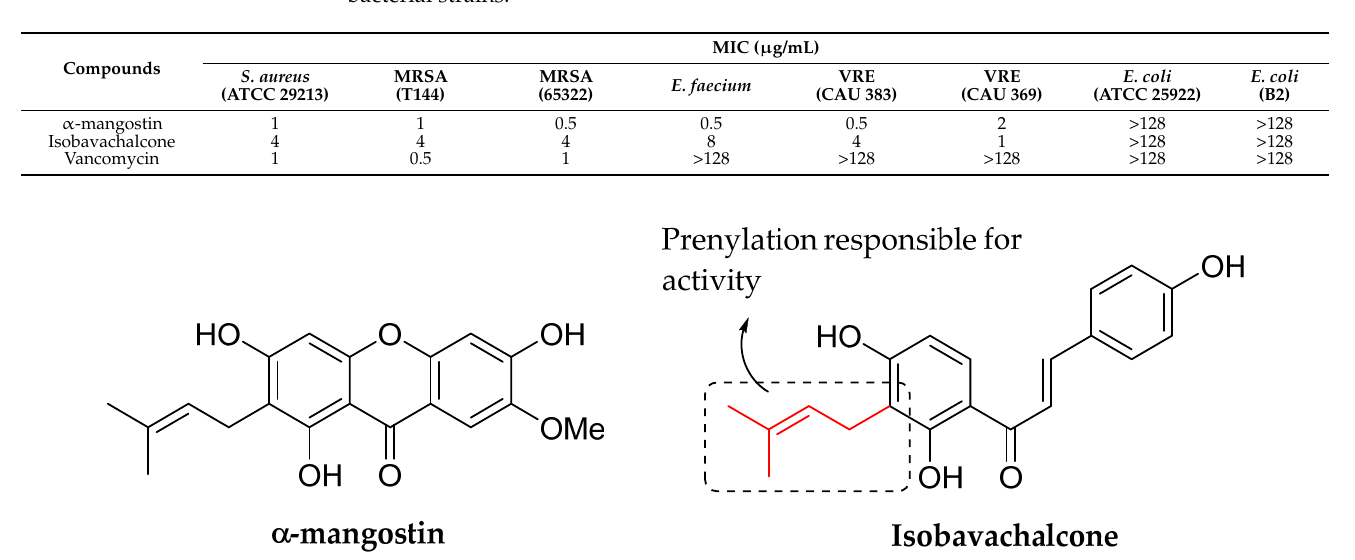
Figure 21. α -mangostin, isobavachalcone and structural feature responsible for antibacterial activity [65]. Bahrin et al. (2014) synthesized and tested antibacterial properties of novel sulfur- containing tricyclic flavonoid derivatives ( 6a – h ) against S. aureus and E. coli . Table 12 demonstrates